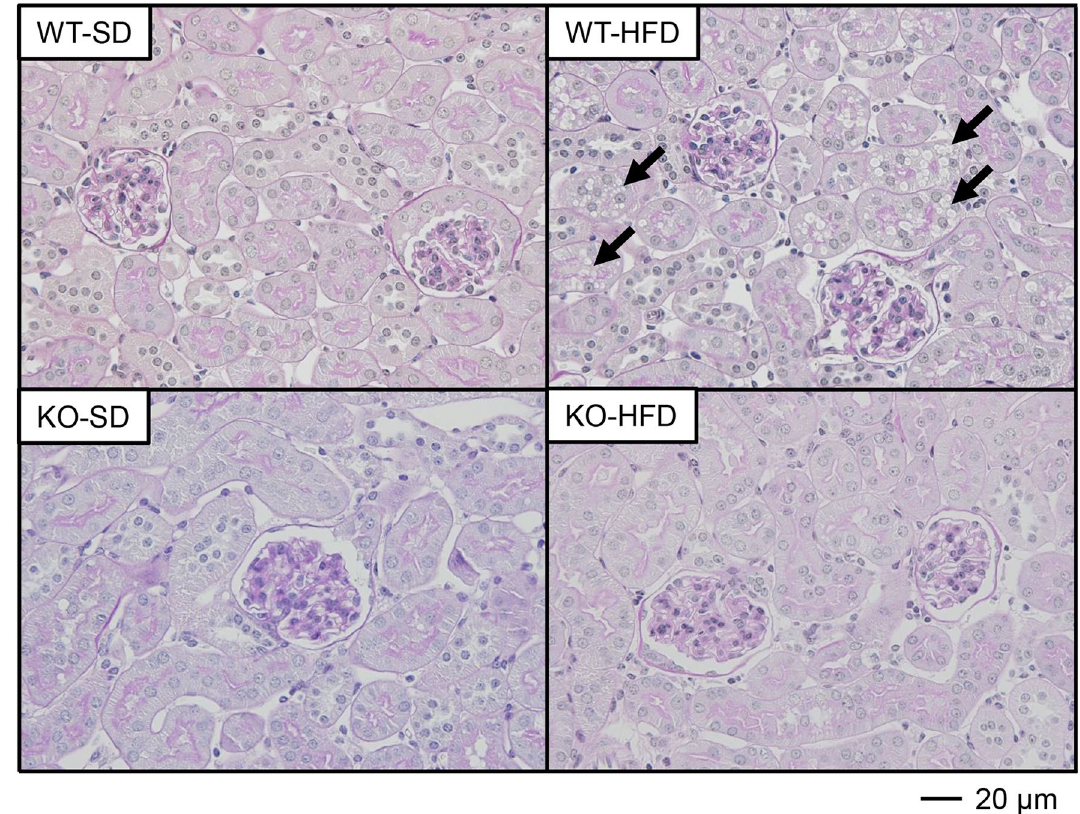
Figure 3. PAS staining of kidney tissue. Vacuolization is observed in the proximal tubules of the WT-HFD group (closed arrowheads) but not of the KO-HFD group by PAS staining of kidney sections from 20-week-old mice (400 ×, scale bar: 20